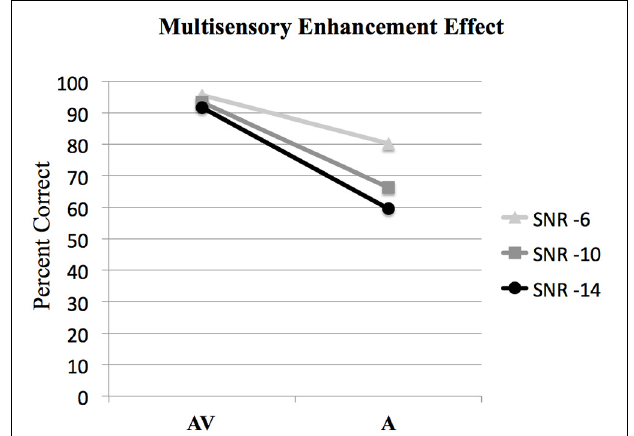
FIGURE 2 | Behavioral results showing the interaction of audio-visual enhancement at each of the signal-to-noise ratios SNRs. The interaction of (AV6-A6)-(AV10-A10) was statistically significant [ F (1 , 15) = 12 . 6, p < 0 . 005]; however the interaction of (AV10-A10)-(AV14-A14) was not significant [ F (1 , 15) = 3 . 9, p > 0 .